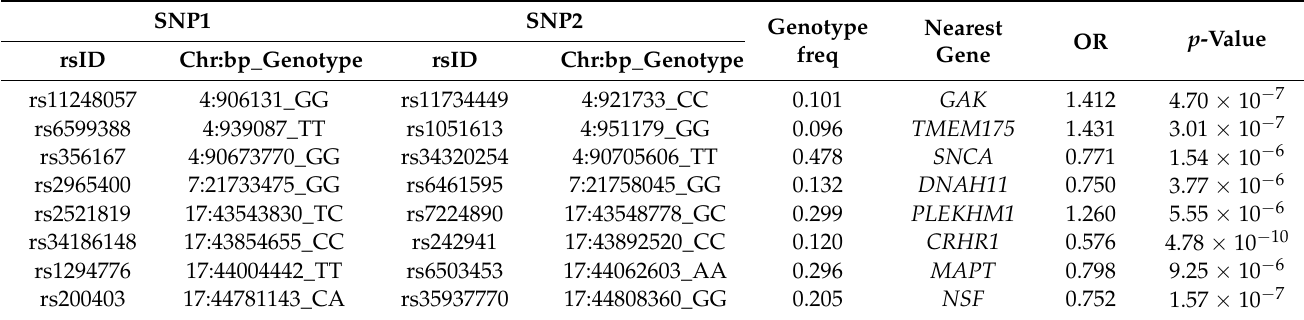
Table 5. GenEpi SNP–SNP interaction